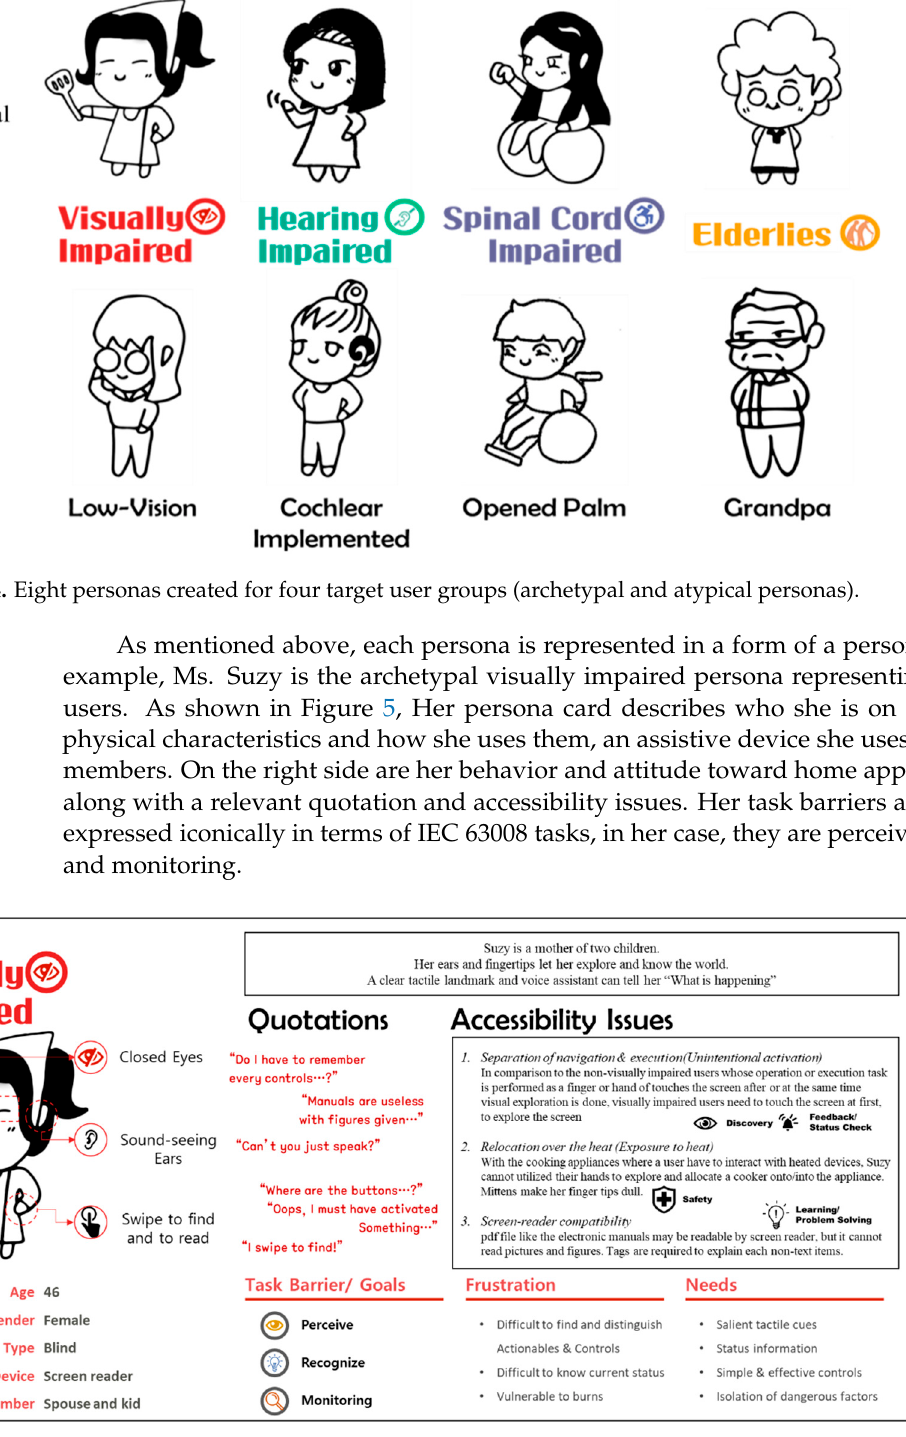
Figure 5. Persona card of Ms. Suzy, the blind persona.